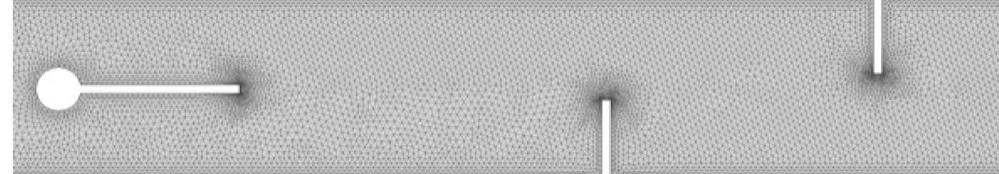
Fig. 3 Computational domain for the channel with a cylinder, an elastic beam, and two baffles (S = 0.2, BR = h/H = 0.4, θ =